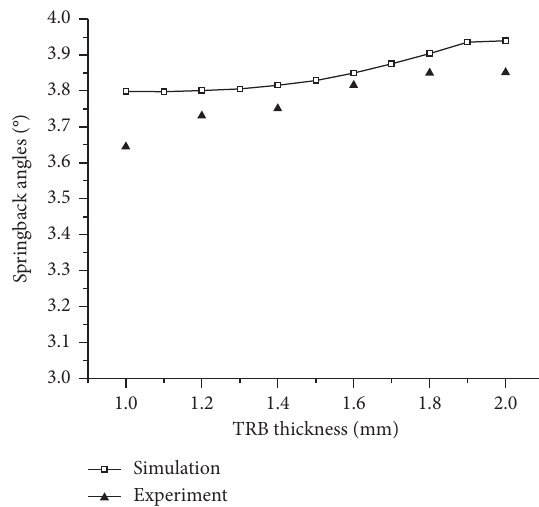
Figure 11: Comparison between the measured and simulated springback angles.